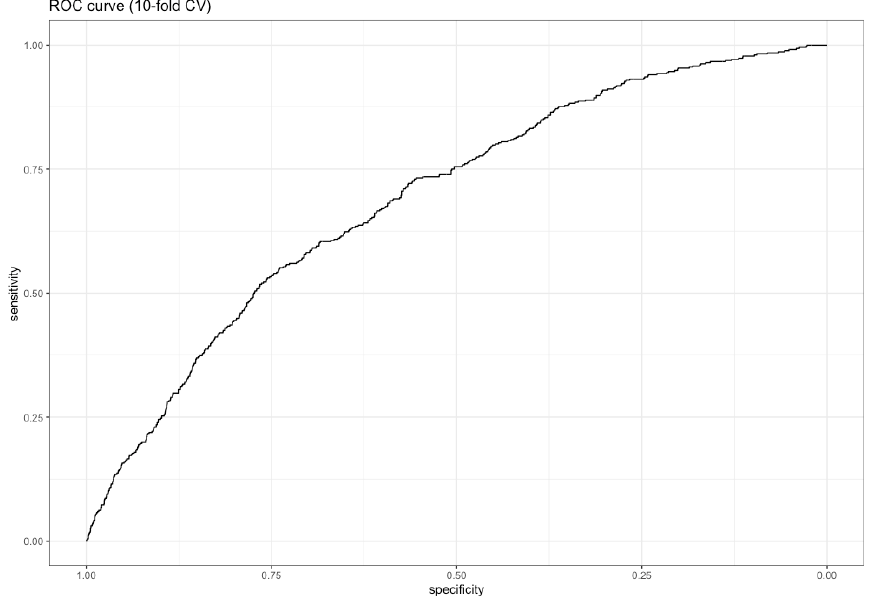
Figure 1. Receiver Operating Characteristics (ROC) curve for the final model, with an AUC of 0.692. For an illustration of the model’s ability to discriminate between CAGE2 and non- CAGE2 subjects, we calculated sensitivity and specificity at different cut-off thresholds (Table 3). A threshold of 0.153 gave the highest balanced accuracy, with a value of 0.65 and a corresponding sensitivity of 0.55 and specificity of 0.74. Table 3. Sensitivity and Specificity of the model at three given cut-off thresholds, and the 0.153 cut-off that provided the optimal cut-off (highest sum of sensitivity and specificity).